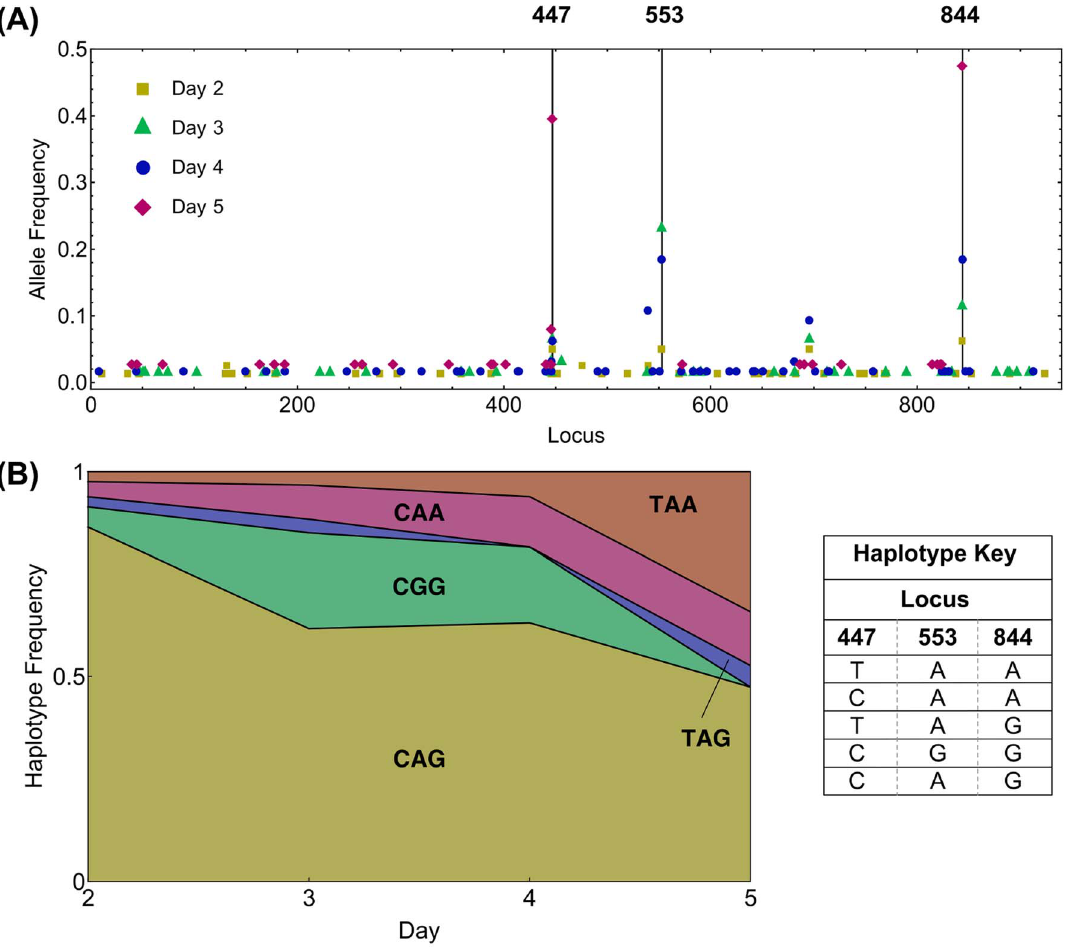
Figure 2. Observations of the viral population in Pig405. (A) Minor allele frequencies greater than zero recorded at each locus over time. Vertical black lines indicate loci at which apparent non-neutral behaviour in a minor allele frequency was found; indices for these loci are displayed above the figure. At locus 844 a continual increase in the minor allele frequency over time can be seen; at locus 553 the minor allele frequency increases between days 2 and 3, then decreases to zero. At locus 447, the frequency of the minority allele reaches a value close to 0.4 at the final time-point; a lower allele frequency is seen at the adjacent locus 446. (B) Haplotype frequencies for alleles at the three loci that exhibit non-neutral